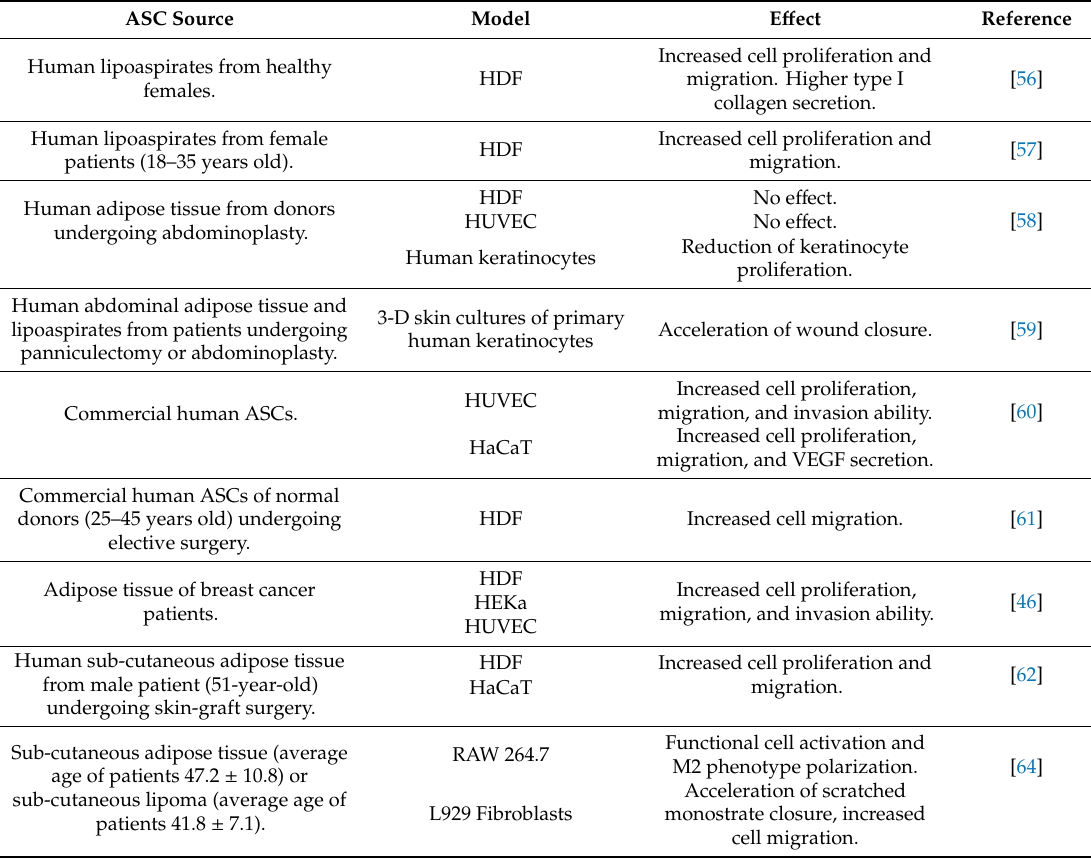
[56] [57] [58] HUVEC No e ff ect.